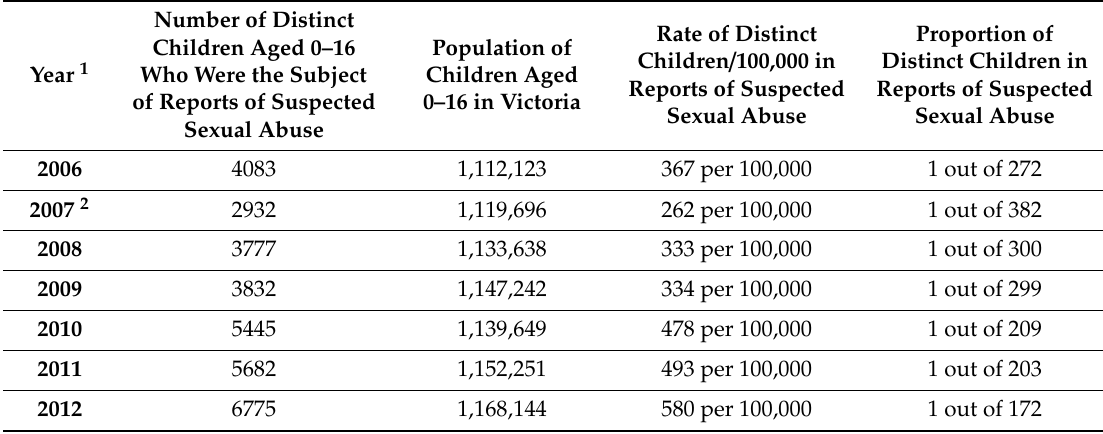
Table 2. Number and rate of children in reports of child sexual abuse: Victoria 2006–2012.